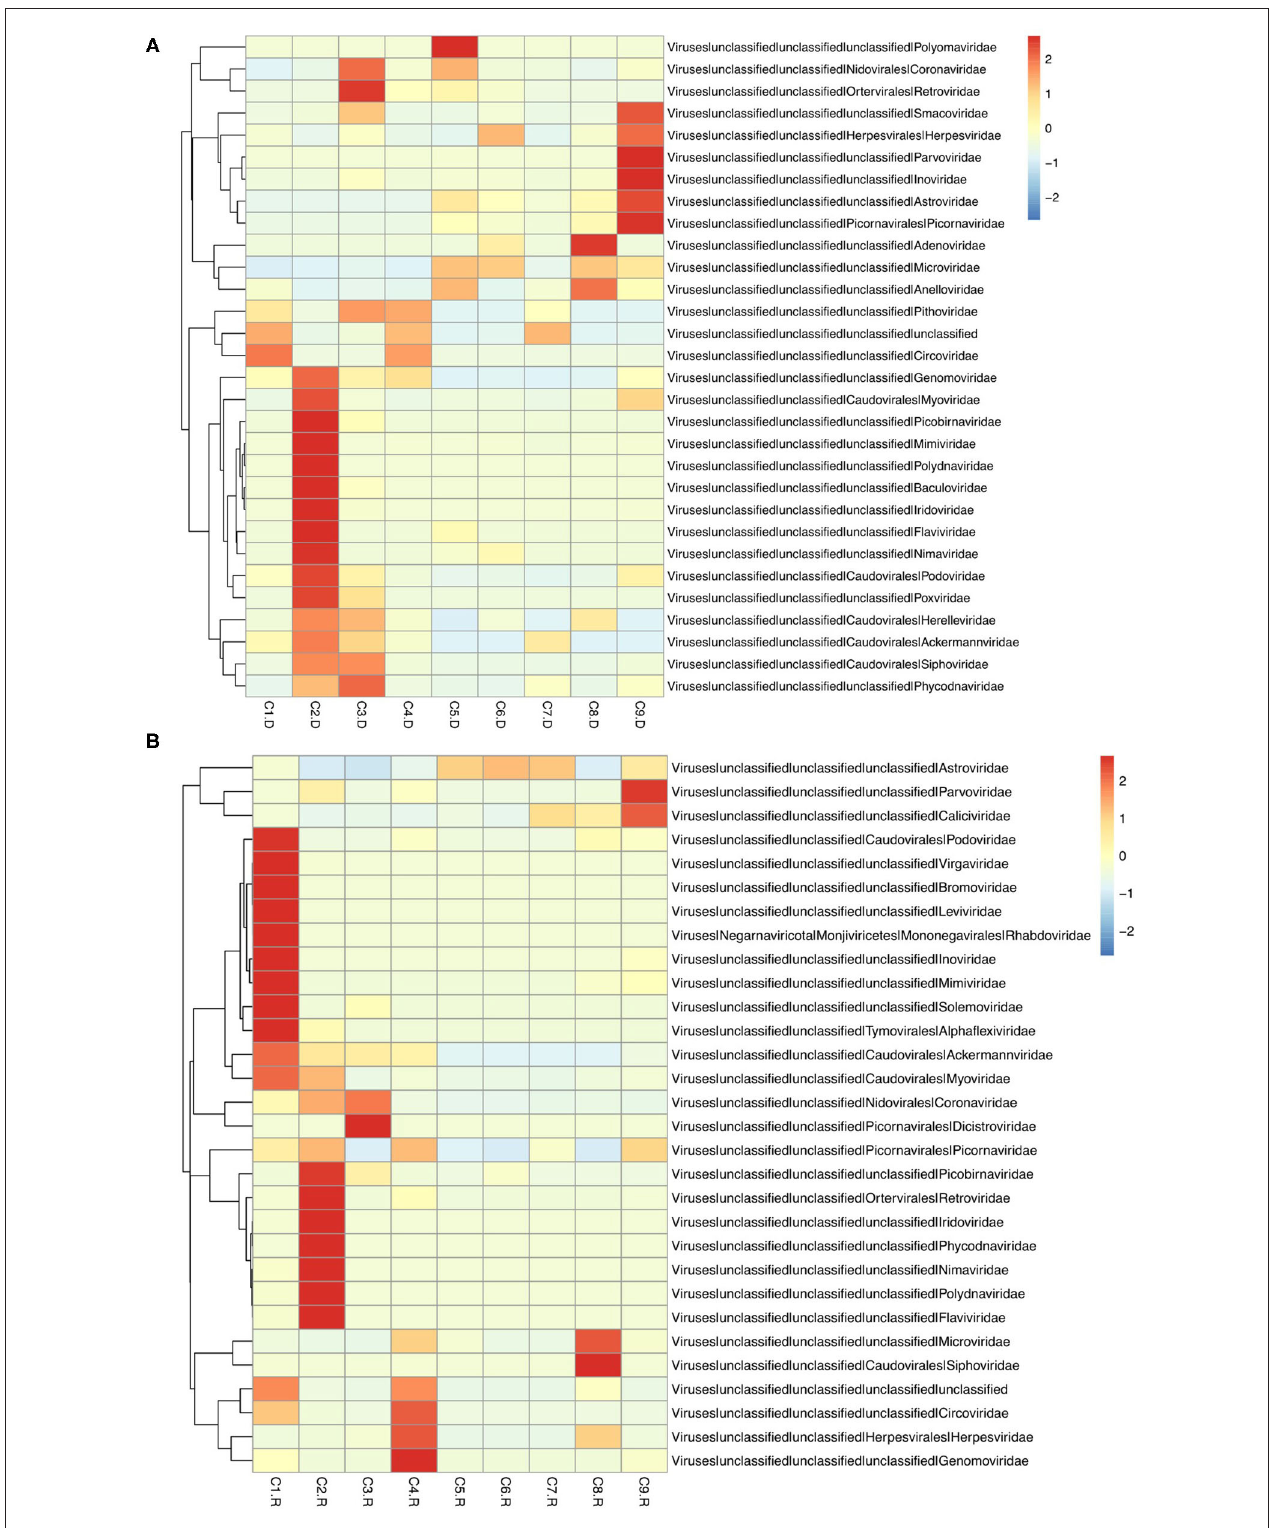
FIGURE 1 | Heatmap of contigs with the top 30 abundance of sequence reads in each sample. (A) The heatmap of DNA virus contigs. (B) The heatmap of RNA virus contigs. Information of contigs and the virus families was provided in the right text column. The samples were listed below the heatmap. The boxes colored from blue to red represent the abundance of virus reads aligned to each